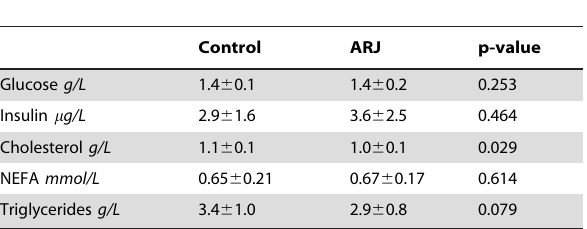
Table 2. Concentrations of the adipokines adiponectin, leptin, and resistin in tissue culture supernatants of MAT of Fischer rats after 10 weeks of intervention with polyphenol- depleted grape-bilberry juice (control) or ARJ (n=24/group).